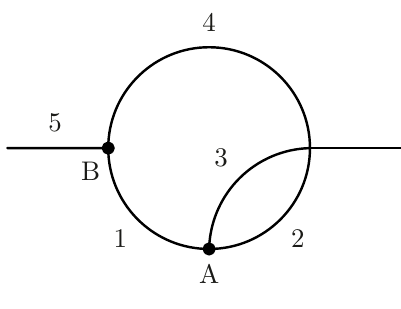
Figure 2 . The propagator